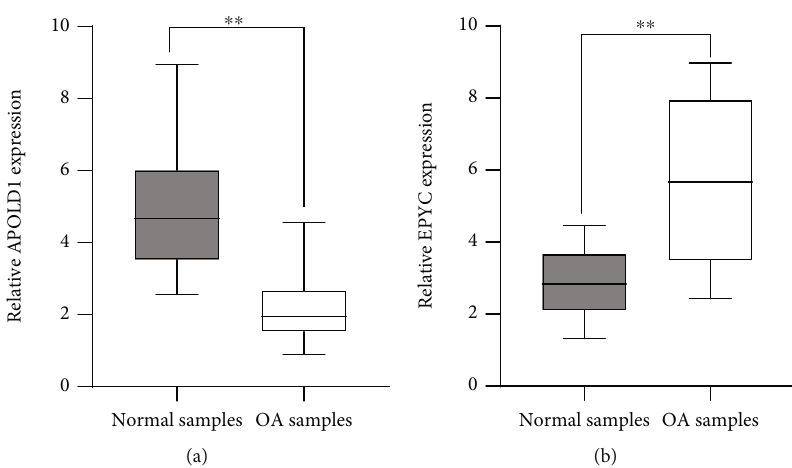
Figure 7: RT-PCR for the levels of APOLD1 (a) and EPYC (b) in OA samples and normal samples from our cohort. The experiments were repeated three times, and each experiment was triplicated. ∗∗ p < 0 : 01